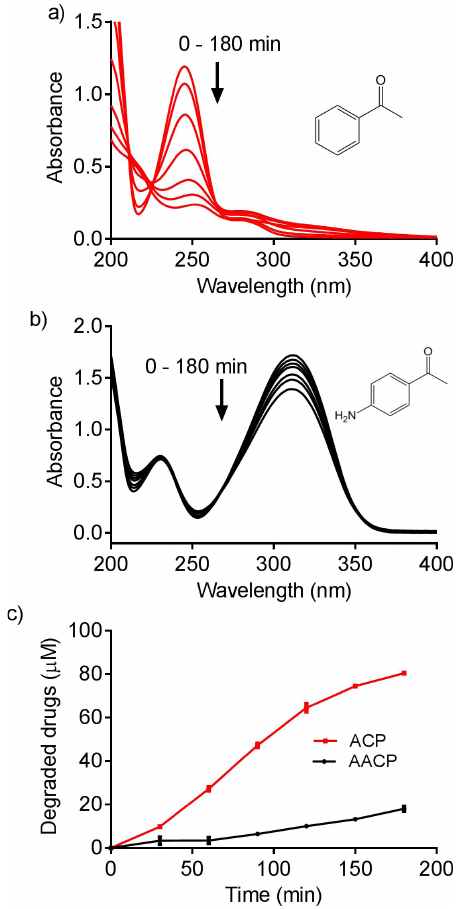
Figure 5. UVC-promoted degradation of (a) acetophenone (ACP, 100 μmol L -1 ) and (b) 4-aminoacetophenone (AACP, 100 μmol L -1 ) catalyzed by ZnO (10 mg) in aqueous medium (25 mL) at 25°C. The results (c) are expressed as means and standard deviations of three experiments.